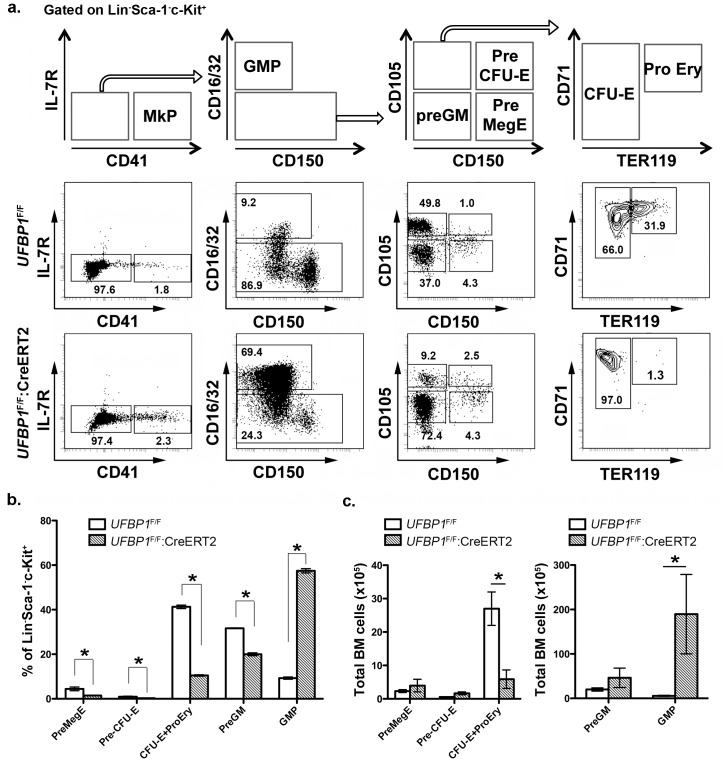

UFBP1 deficiency impairs lineage development of erythroid progenitors.
a. Flow cytometry analysis of erythroid and myeloid lineages in control and UFBP1 deficient mice after TAM injection. BM cells were collected from TAM-injected control (n = 4) and floxed (n = 4) male mice when UFBP1 deficient mice exhibited significant weight loss and became moribund. The following markers were used for flow analysis: BV510-Sca-1, APC780-c-Kit, PE-Cy7-CD150, Alexa 700-CD16/32, PE-IL-7R, APC-CD41, BV650-CD105, FITC-CD71, BV421-TER119, and lineage markers including PerCP-Cy5.5-conjugated CD4, CD8, CD3, CD5, Gr-1, CD11b, CD19 and B220. b. The percentages of each lineage in L-S-K+ cells. *p <0.01, and **p <0.05 (n = 4). MkP: megakaryocyte progenitor; GMP: granulocyte macrophage progenitor; Pre GM: granulocyte macrophage precursor; Pre MegE: megakaryocyte erythroid precursor; Pre CFU-E: CFU-E precursor; CFU-E: erythroid colony-forming unit; Pro Ery: proerythroblast. c. The absolute cell numbers of each lineage in control and UFBP1-depleted BMs. UFBP1 depletion led to reduction of total BM cells (1 x 108 cells in control versus 5 x 107 in UFBP1 deficient mice). *p <0.01 (n = 4).